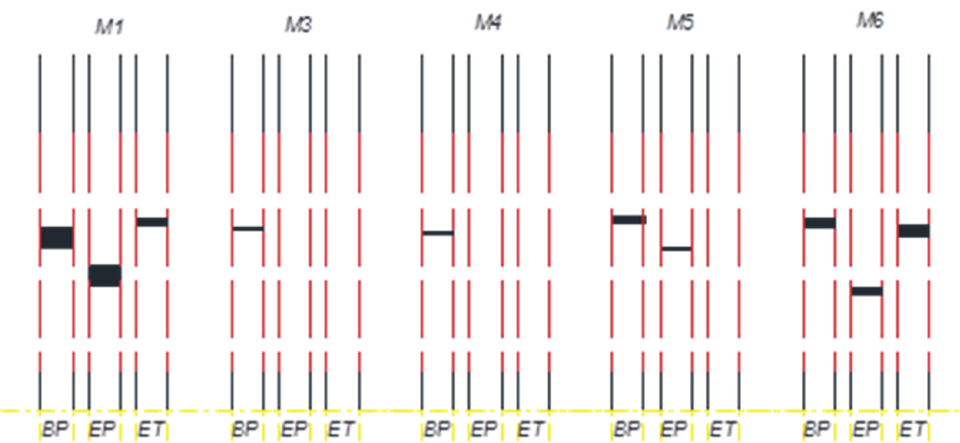
Figure 14. LNAPL thickness in monitoring wells at the beginning of pumping (BP), end of pumping (EP), and end of test (ET) for scenario in E3.